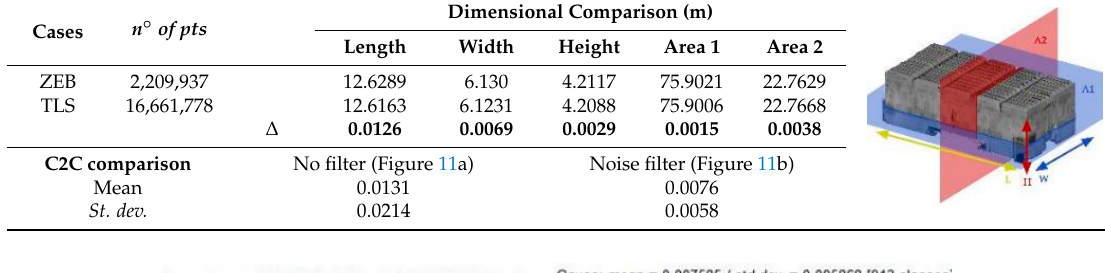
Figure 11. Statistical graphics of C2C comparison of ZEB and LiDAR point clouds on the Throne Chamber : mean and st. dev. distribution ( a ) before and ( b ) after noise filtering applied to ZEB data (C 1 - C 2 cases). Table 5. Results of (I.) Dimensional and C2C comparison of ZEB and LiDAR point clouds on the Throne Chamber.